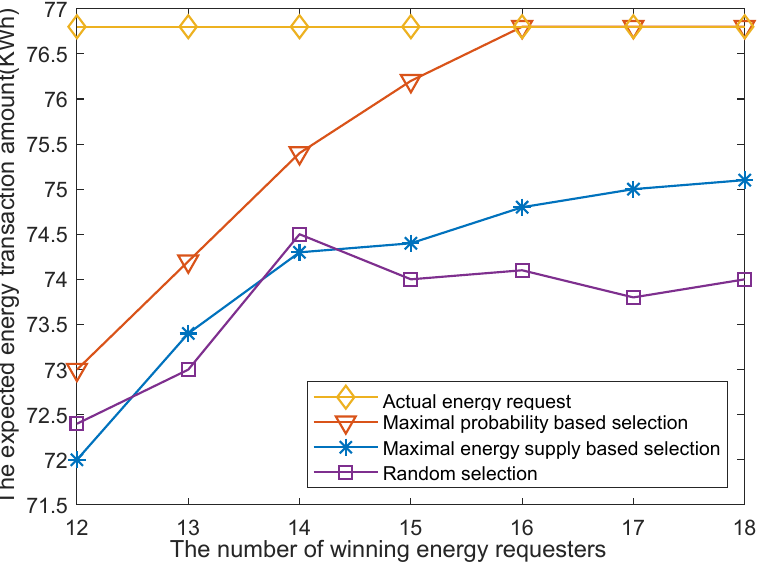
Figure 5. The total energy transaction amount when the number of energy suppliers varies. Figures 6 and 7 illustrate the performance reduction of the total energy transaction amount when the energy trading does not use blockchain smart contract technology. In the real scenario, the probability of not complying with the contract is not too high. However, to highlight the performance difference, it is assumed that the energy suppliers break the contract rules with a probability of 10%. Thus, the performance is much worse when the energy trading is not protected by a smart contract.